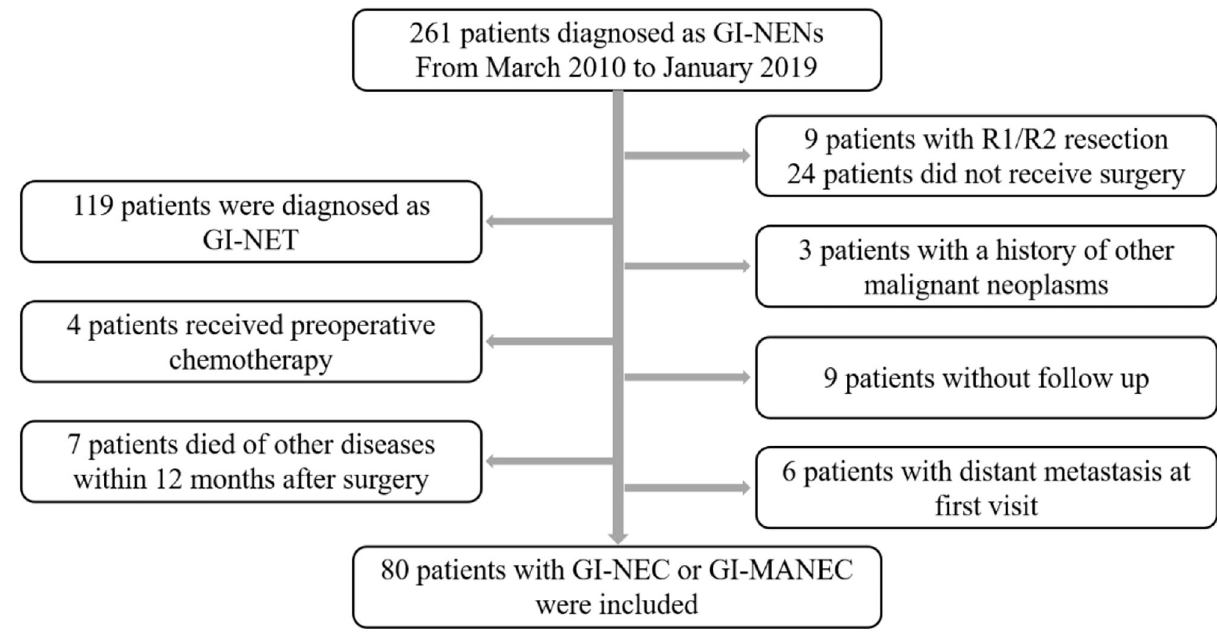
FIGURE 1 | Study scenario of the patients undergoing surgical resection for